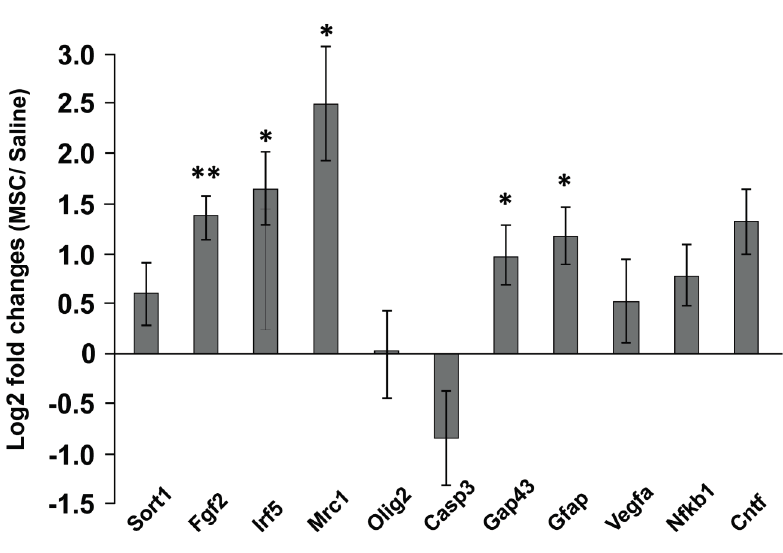
Figure 6. Gene expression profiling in the lesion center 28 days after SCI. The graph shows the log2 fold changes of the corresponding genes 28 days after the intrathecal transplantation of MSCs in comparison to the vehicle (saline) values. Data are represented as the mean SEM, * p < 0.05, ** p < 0.005 ( Δ C values of MSC vs . t